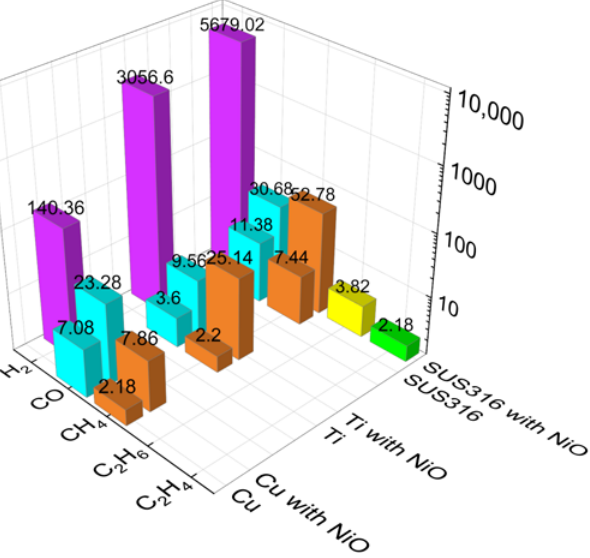
Figure 5. The production of flammable gases after 24 h of magnetic stirring for Cu, Ti, and stainless steel (SUS316) reactors. For every reactor, two experiments were conducted in which no NiO particles and 1.00 g of NiO particles were added to the deionized water, separately.